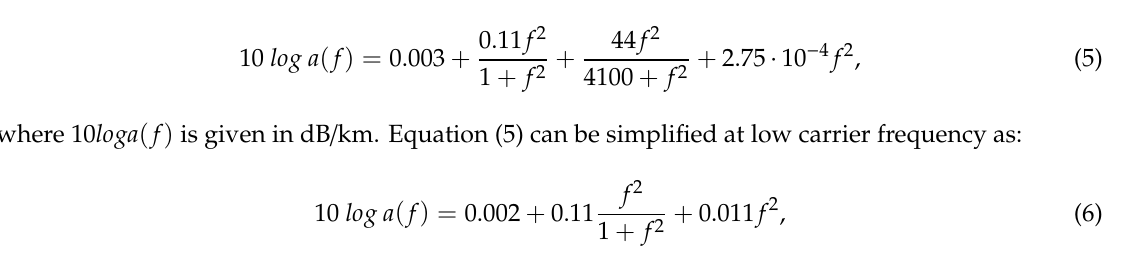
Figure 2. Absorption coefficient 10log𝑎(𝑓) .